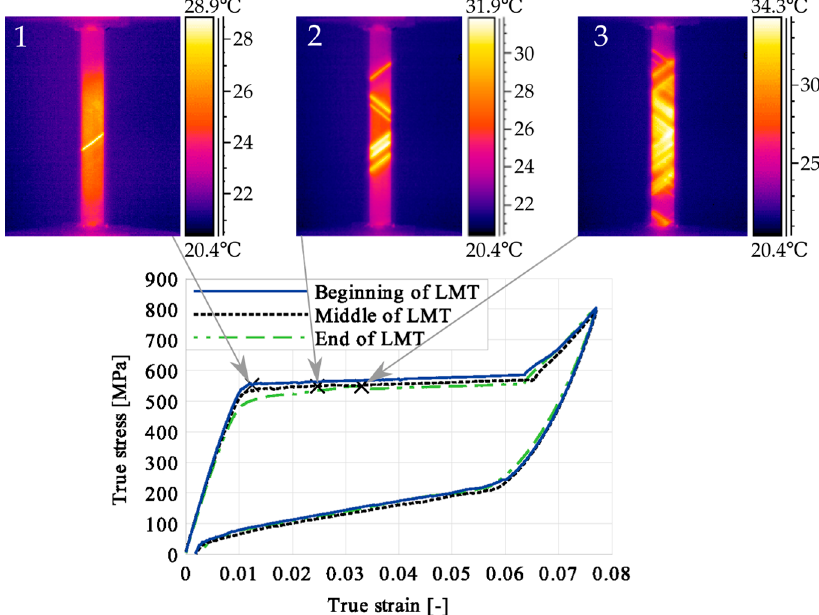
Figure 2. Stress–strain curve of TiNi SMA under force-controlled conditions; the marked points correspond to the thermograms 1, 2 and 3.